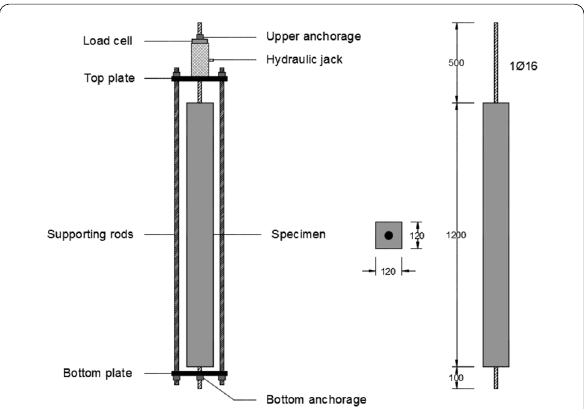
Fig. 3 Test rig for tension stiffening